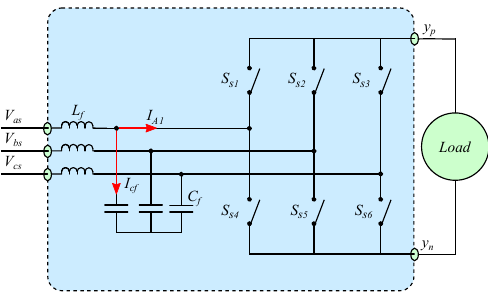
Figure 6. Simplified MC module (3 × 2).